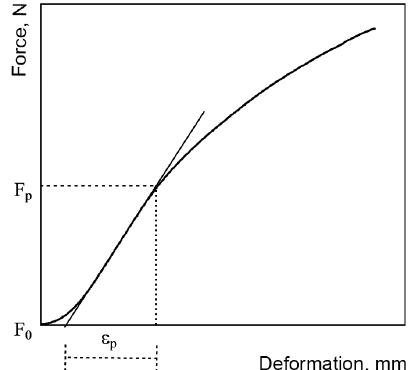
Fig. 2. Example of force-deformation curve of lightweight F F composite: p – compressive force at critical point; 0 – force ε corresponding to the preload; p – deformation at p